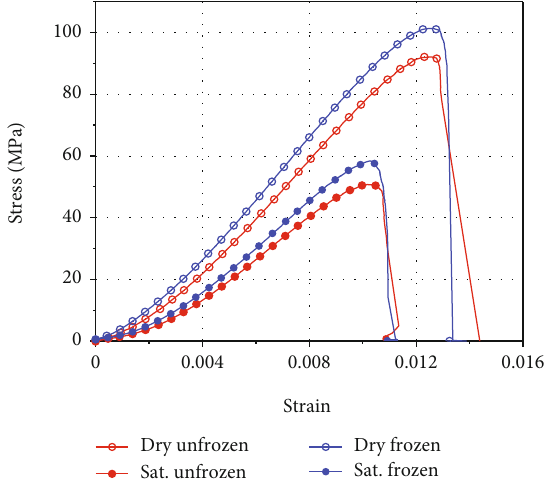
Figure 5: Stress-strain curves of dry and water-saturated specimens tested under uniaxial